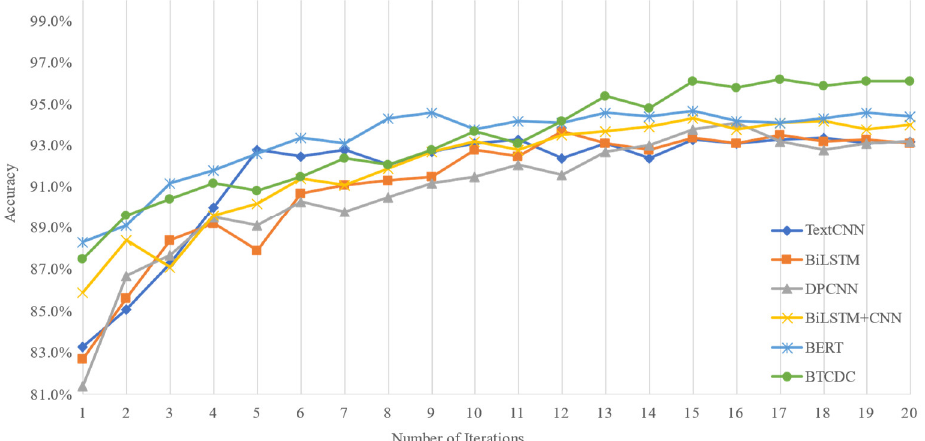
Figure 5. Trend of accuracy on Sohu News dataset.